Question: Give a one-sentence summary of this figure.
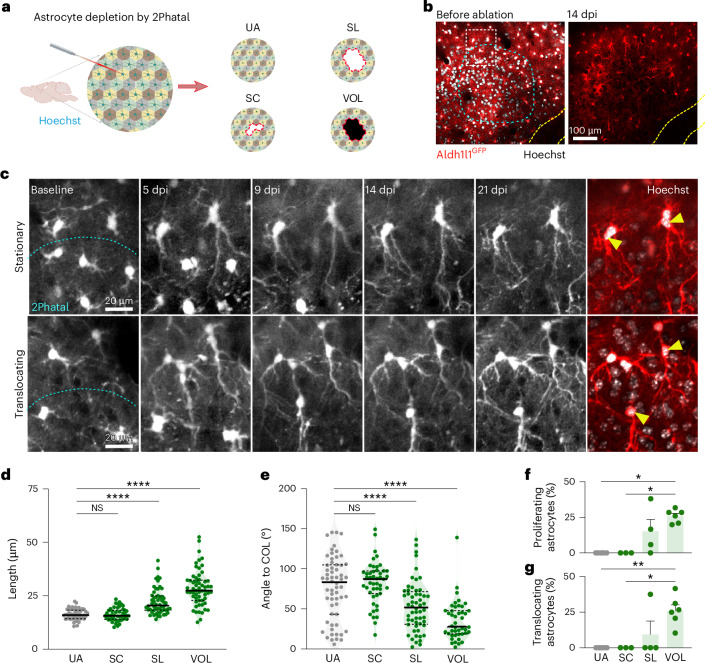
Answer: Astrocyte nucleokinesis is inducible by volume-targeted 2Phatal approach. a , Experimental setup for astrocyte ablation by modified 2Phatal method in different configurations—UA, that is, area without ablation but with in vivo Hoechst staining, SC (~5 cells, 0.08–0.14 × 10 6 µm 3 ), SL (~1.3–2.2 × 10 6 µm 3 ), VOL (~6.3–10 × 10 6 µm 3 ). b , Overview of the ablation region in Aldh1l1 GFP mice before (left) and 14 days after 2Phatal laser ablation (right). The cyan dashed line encompasses the ablation area, white dashed square indicates region of zoom-ins shown in c . In vivo Hoechst-33342-stained nuclei for 2Phatal induction are shown in white; astrocytes are shown in red, yellow dashed lines indicate a nearby blood vessel. Image is representative of similar results observed in six lesions from six mice. c , Representative two-photon in vivo time-lapse images of perilesional astrocytes 1–21 days after 2Phatal VOL ablation in Aldh1l1 GFP mice. The cyan dashed line indicates the border of the 2Phatal ablated area. The slow disappearance of 2Phatal-targeted astrocytes within 2 weeks was noted. At the last imaging time point, Hoechst 33342 (in white) was added to counterstain for nuclei (astrocytes are shown in red). Stationary (top) and translocating (bottom) daughter-cell nuclei are indicated by yellow arrowheads. Image is representative of similar results observed in six lesions from six mice. d , e , Vector-based quantification of process length ( d ) and polarization ( e ; UA— n = 45 astrocytes from three animals, SC— n = 47 cells from three animals, SL— n = 56 cells from four animals, VOL— n = 59 cells from six animals). **** P < 0.0001; Mann–Whitney test, two sided. Thick black lines represent the median, and fine black dashed lines represent the first and third quartiles. f , g , The percentage of proliferative ( f ) and repopulating ( g ) astrocytes, respectively, showing an increase with larger ablation volumes (UA— n = 5 animals, SC— n = 3 animals, SL— n = 4